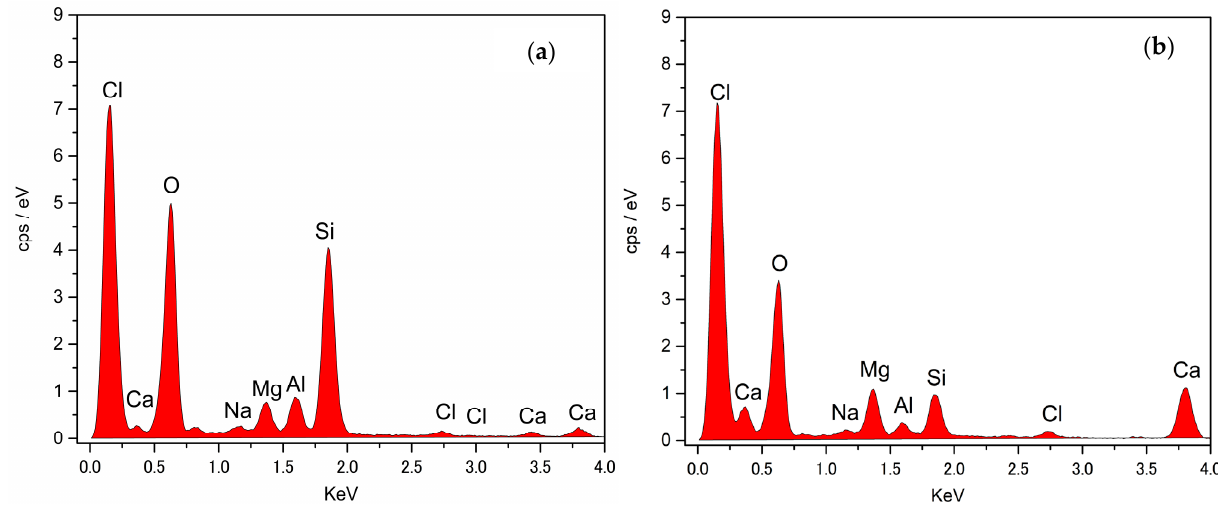
Figure 3. Typical EDS spectra of ( a ) Sample A, and ( b ) Sample B.